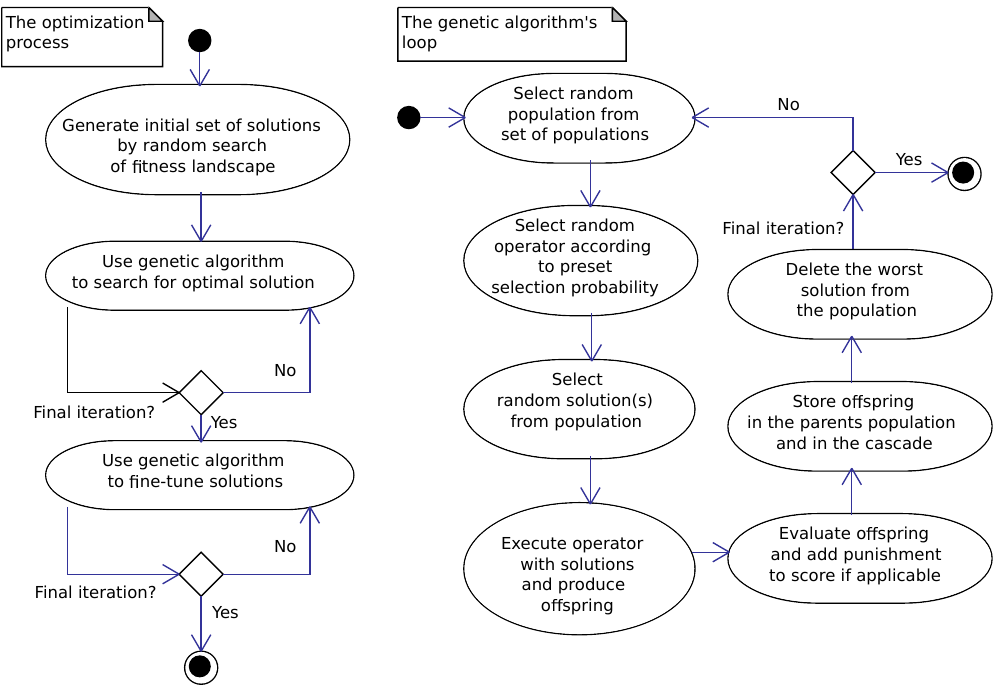
Figure 7. The flow diagram of the genetic